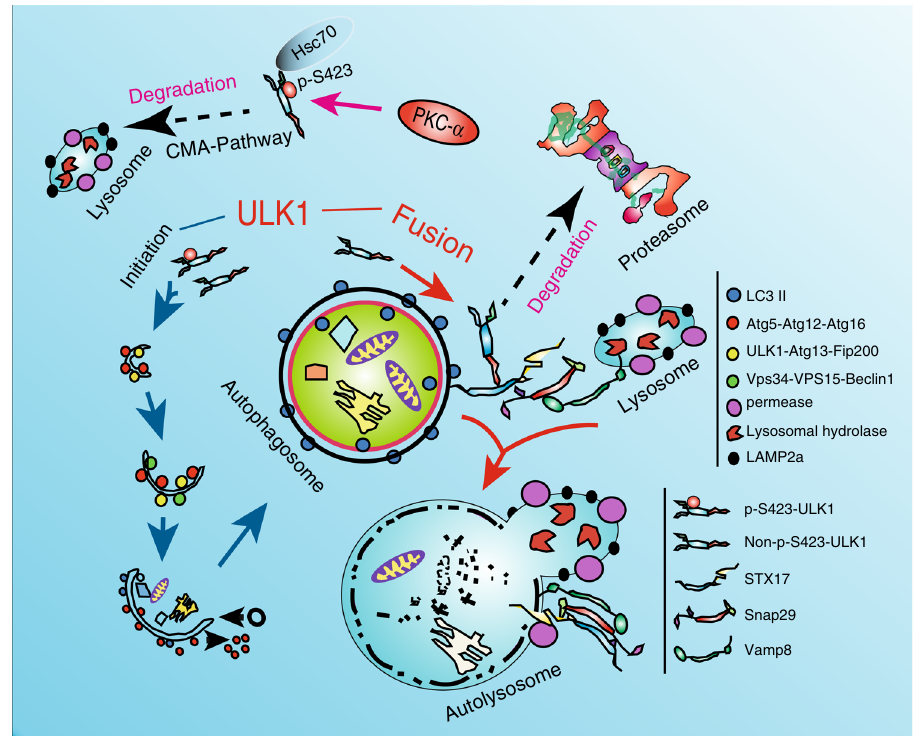
Fig. 7 Model of ULK1 regulating fusion of macroautophagy and linking chaperone-mediated autophagy to macroautophagy. Unphosphorylated ULK1 recruited STX17 and increased STX17 ′ s af fi nity towards SNAP29. PKC α phosphorylation of ULK1 attenuates autophagosome – lysosome fusion by reducing the af fi nity of ULK1 for STX17. Phosphorylation of ULK1 enhances its interaction with HSC70 and increases its degradation via